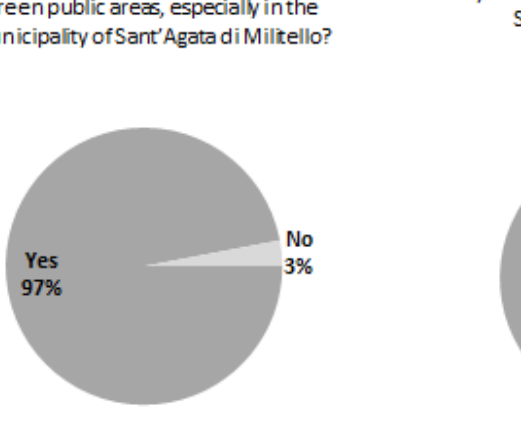
Figure 2: Degree of interest, fruition and satisfaction of the sample